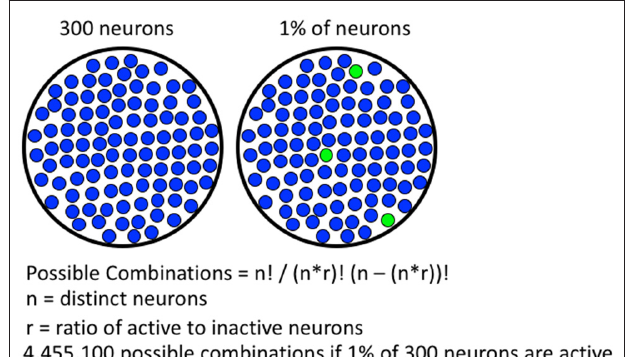
FIGURE 1 | Formula for calculating number of possible combinations of activated neurons. A hypothetical brain region containing 300 neurons is shown on the left, if 1% of the neurons are active, 4,455,100 possible combinations are possible. With more neurons available in real brain areas, the number of possible combinations is much